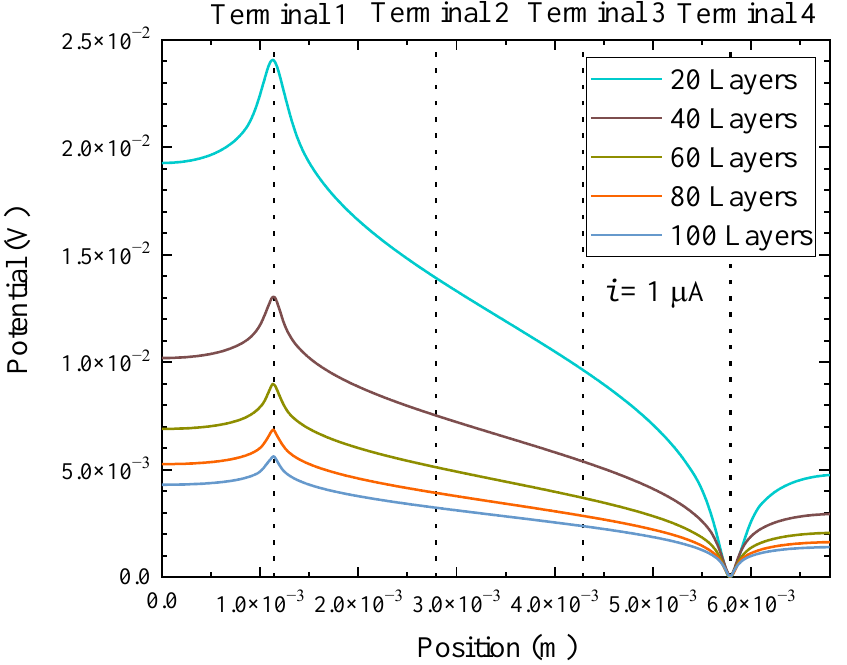
Figure 20. Electric potentials along the half-thickness of the simulated film. Terminal 1 is the current input. Terminal 4 is grounded. Terminals 2 and 3 are the sense terminals.